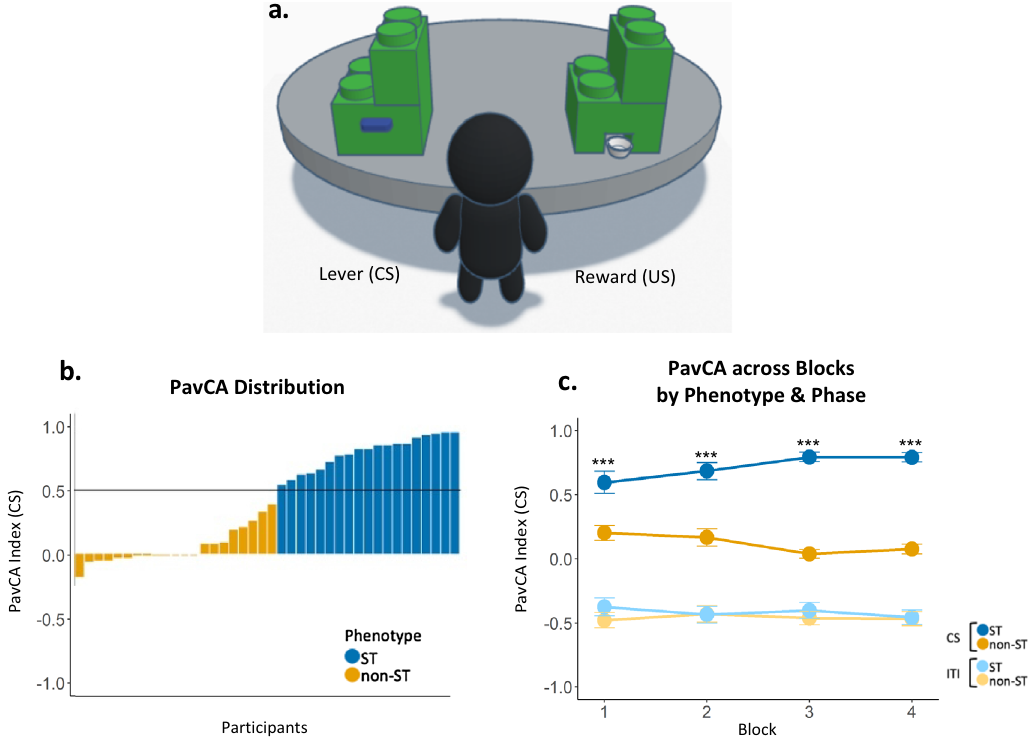
Figure 1. Human Pavlovian conditioned approach apparatus and behaviors. ( a ) Digital depiction of the Pavlovian Conditioned Approach task adapted for use in human youth. Lever response box shown on the left and reward response box on the right. CS = conditioned stimulus; US = unconditioned stimulus. ( b ) PavCA = Pavlovian Conditioned Approach; Individual subject distribution of PavCA index scores averaged across Blocks 3 and 4. Phenotypes were characterized by a PavCA score greater than 0.5 (horizonal line) for sign-trackers and less than 0.5 for non-sign-trackers; ST = sign-tracker; non-ST = non-sign-tracker. ( c ) PavCA scores across all 4 blocks between phenotypes (ST, non-ST) and between phases (CS, ITI); CS = conditioned stimulus/lever presentation; ITI = inter-trial interval. Error bars represent standard error of the mean. Post-hoc tests between phenotypes during CS for each block are marked with asterisks; p < .001***, p < .01**, p <